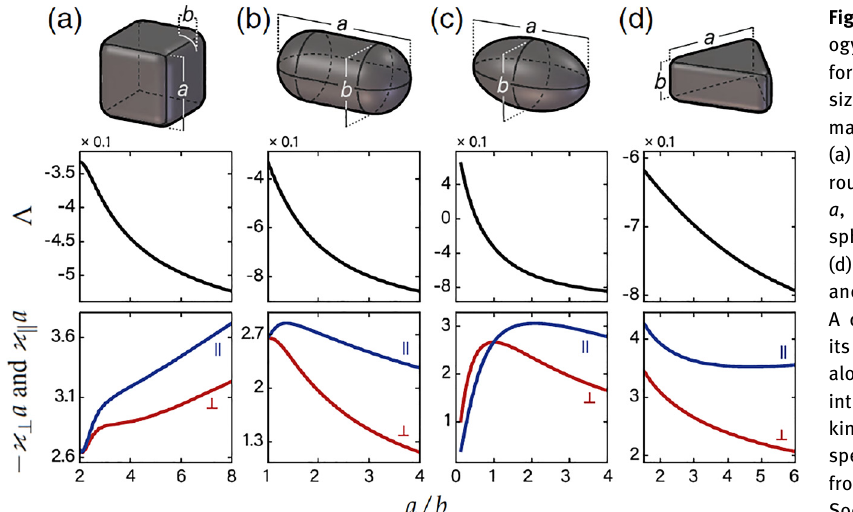
Figure 14: Numerically evaluated morphol- ogy and shape factors, Λ , 𝜘 ⊥ a , and 𝜘 ∥ a , for varying aspect ratio a ∕ b . Note how the size-dependentshapefactorshavebeennor- malized by the characteristic length scale a . (a) Cubes of side a and edge- and corner- rounding 2 b , (b) cylindrical pills of length a , diameter b , and butt-rounding b , (c) spheroids with principal axis a and b , and